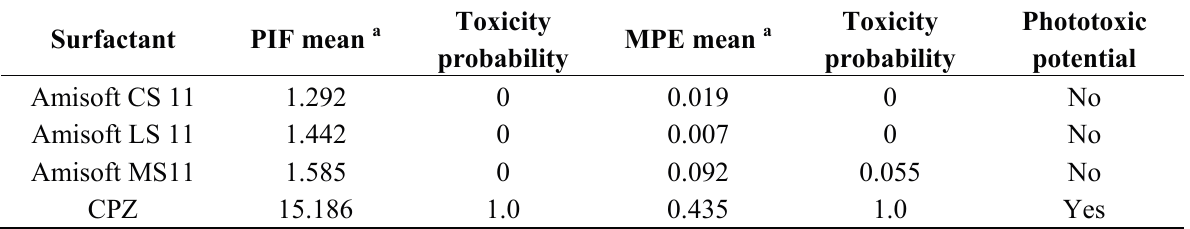
Table 3. PIF mean and MPE mean values of acylglutamate surfactants and CPZ on HaCaT cells.